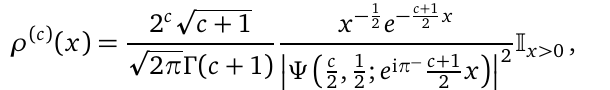
Figure 3: Plots of the c -gamma with mean 1 and variance 1 c , the dashed lined corresponds to the classical limiting case and the doted line